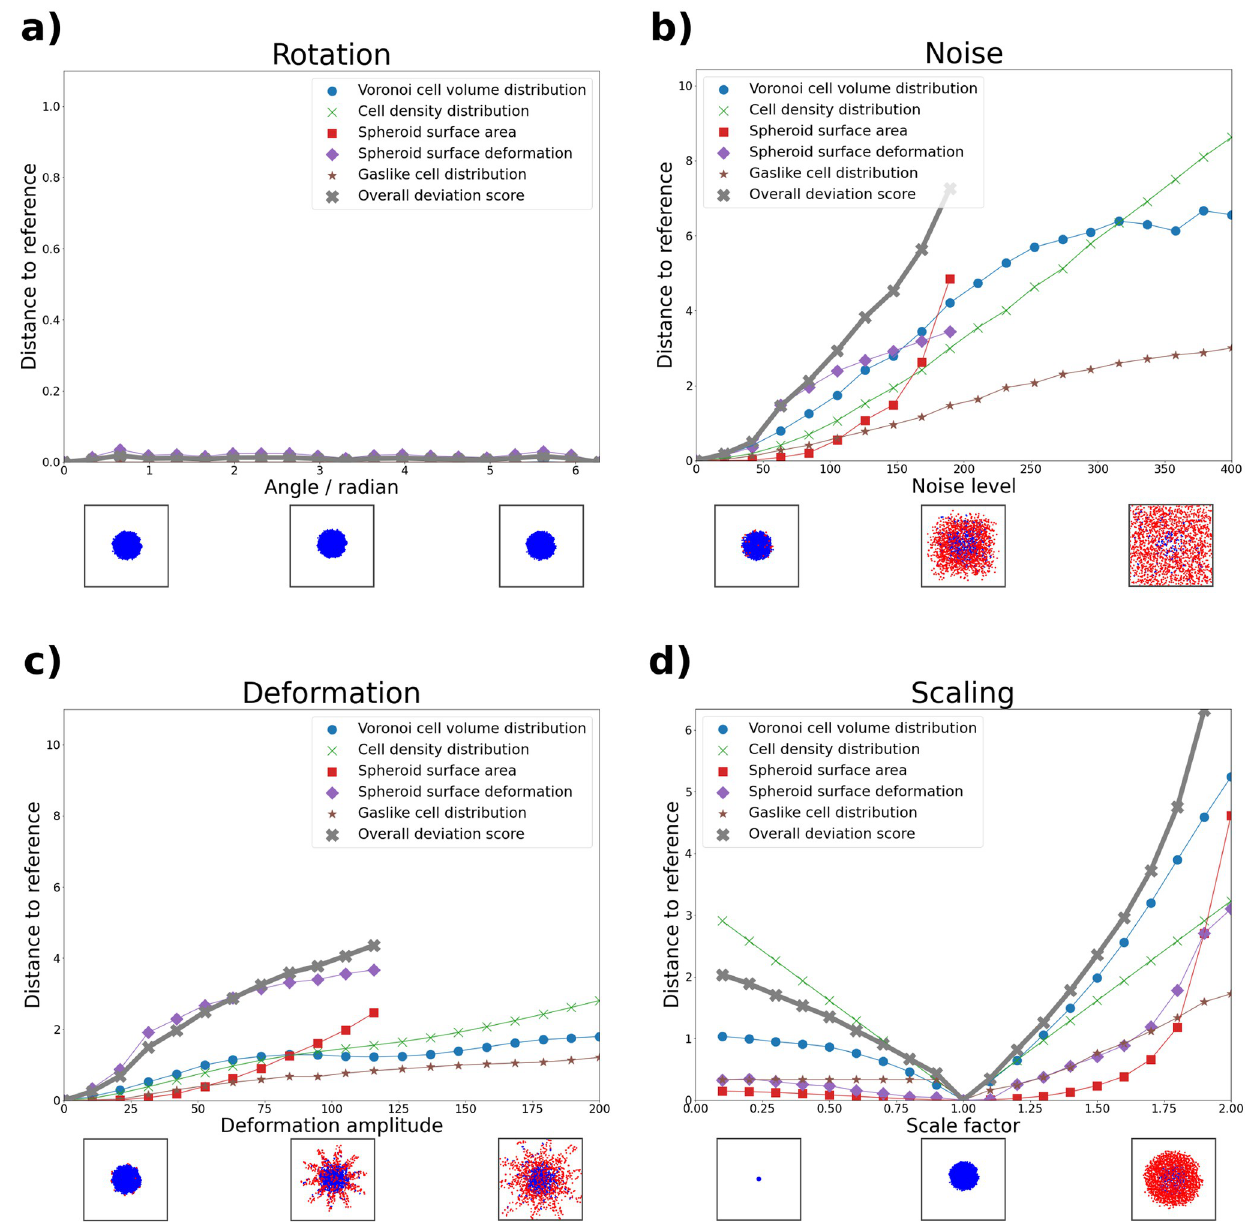
Fig 5. Feature comparison for spheroid point clouds resulting from four different transformation functions. Shown are the standardized metric distances between the un-transformed reference spheroid and an increasingly transformed version for each data feature. In addition, the combined deviation score is depicted in gray crosses for each transformation (see Section 2.4). Below each subfigure, we provide a top-down view snapshot of the spheroid at three levels of transformation. Blue cells are classified as non-gaslike, and red cells are classified as gaslike. a) Rotation . Except for negligible changes in the spheroid surface deformation feature, we observe no change at increasing rotation angle. This supports rotational invariance of our features. b) Noise . For each feature, the distance increases at increasing noise level. Due to the loss of a solid core at high noise levels, the spheroid surface area and deformation features are no longer sensible, and were therefore cut. The deviation score increases approximately linearly up to a noise level of 200, at which point the features related to the spheroid surface area were cut. c) Deformation . Similar behavior to b) is observed here. Above a deformation amplitude of 120 the spheroid point cloud still contains cells classified as non-gaslike but loses its solid core. Surface area and deformation values were therefore cut above this threshold. The deviation score increases approximately linearly up to a deformation amplitude of 120. d) Scaling . We observe increased distances both for scale factors below and above 1. Due to the fixed values of D crit and d crit (see Eq 1), the gaslike distribution feature is scale-dependent, and also varies here. For scale factors below 1.0, no gaslikes were found, and therefore the values of this feature remained constant. The deviation score increases approximately linearly both for scale factors smaller and larger than